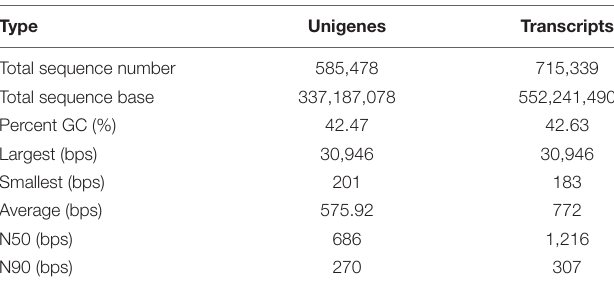
TABLE 3 | Profile of